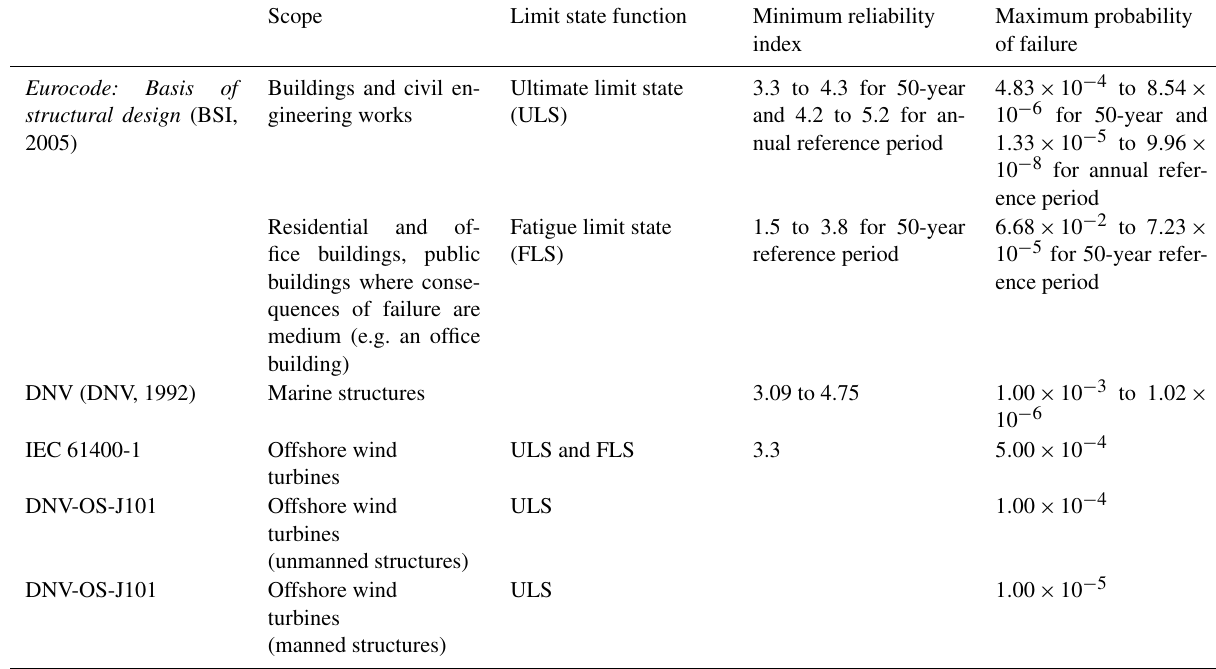
Table 4. Examples of target levels of reliabilities specified by